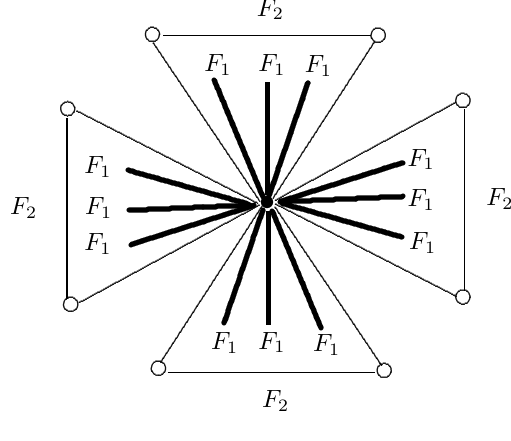
Figure 14: The plane graph 4 (cid:63) F